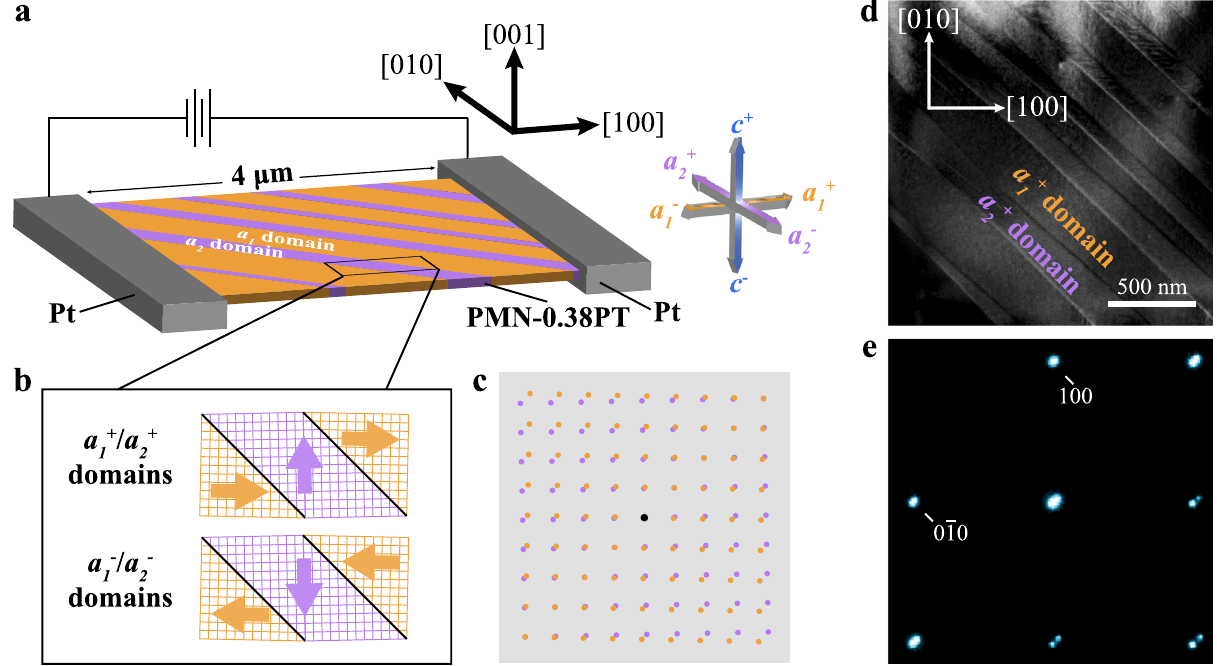
Fig. 1 In-situ biasing TEM setup and determination of initial a 1 / a 2 90° domains. a A schematic diagram of the experimental setup. A focused ion-beam fabricated PMN-0.38PT lamella was fi xed between two Pt electrodes. A cyclic electric fi eld was applied to the lamella along ±[100] crystallographic direction of the lamella. The yellow, purple, and blue arrows denote the polarizations of a 1 ( a 1 + / a 1 − ), a 2 ( a 2 + / a 2 − ), and c ( c + / c − ) domains, which are along ±[100], ±[010], and ±[001] orientations, respectively. b Schematic diagrams showing [001] projected lattices of a 1 / a 2 domains, and c their corresponding schematic of electron diffraction pattern showing the split spots. d A TEM image showing 90° stripe domains in PMN-0.38PT, and e the corresponding electron diffraction pattern showing the split spots of the 90°